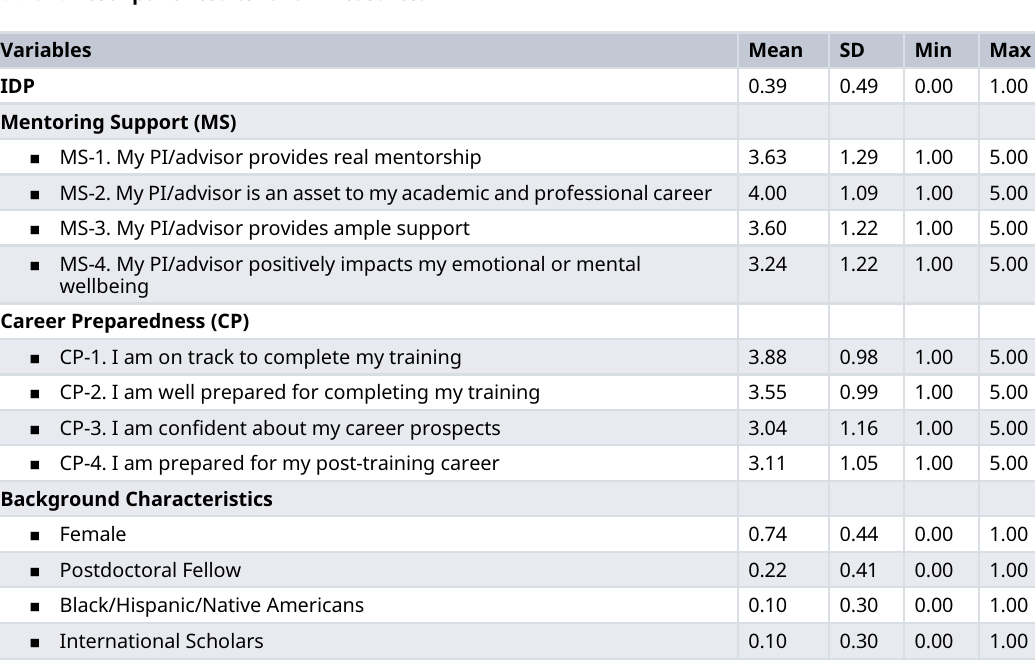
Table 1. Descriptive results for all measures.